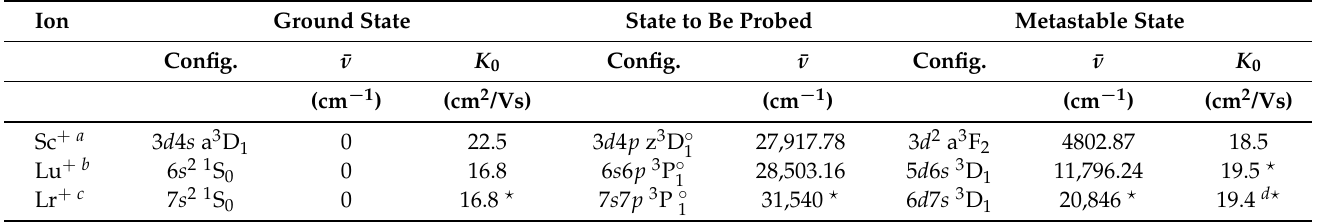
Table 1. Relevant electronic states in Sc + , Lu + , and Lr + ions. The experimental ion mobilities are given for a helium temperature of 295K. Predictions are marked by (cid:63)